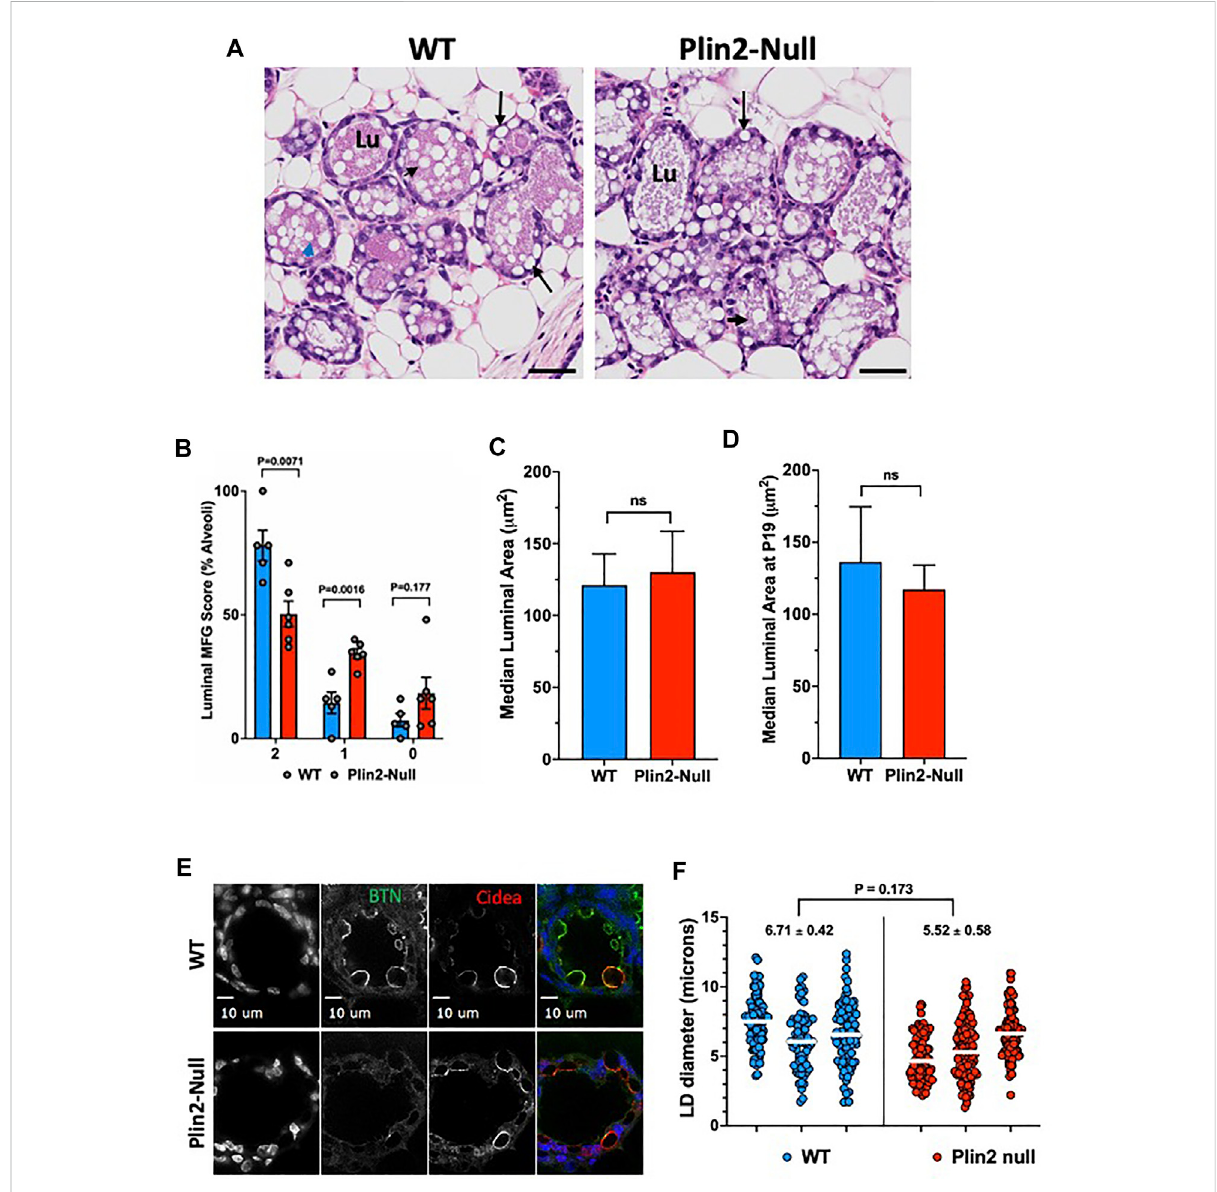
FIGURE 6 Apocrine lipid secretion in primiparous mice. (A) Representative histological images of mammary alveoli from primiparous WT and Plin2-Null miceonlactationday1(L1).Alveolarlumens (Lu)ofWT miceareextensively fi lled withMFG(black arrowheads) thestructuresofsecretedmilk lipids. Incontrast,LDappeartoberetainedintheepithelium(backarrow)andMFGarepresentinlimitednumbersinalveolarlumensofPlin2-Nulldams. (B) Histological quantitation of luminalMFG.The data show the percentage of WT (N= 5,blue) andPlin2-Null(N= 6, red)mammaryalveoli scored ashaving > 3MFG(score=2); twoorfewer(score= 1)or0(score=0) MFGintheirlumensatL1. p values werecalculatedbyStudentst-testfromthe resultsof6randomsectionsperdam. (C , D) HistochemicalquantitationofluminalareasinalveoliinsectionsfromWTandPlin2-Nullmammarygland at L1 (C) and P19 (D) . (E) Representative images of BTN (green/monochrome) and Cidea (red/monochrome) immuno fl uorescence in mammary glands of WT and Plin2-Null at P19. (F) Quantitation of LD diameters in mammary alveoli WT and Plin2-Null dams at P19. White bars are median values.AveragemedianLDdiametersareshownaboveeachgenotype. p -valueofgroupdifferenceswasdeterminedbynestedt-testandisshownat the top of the fi